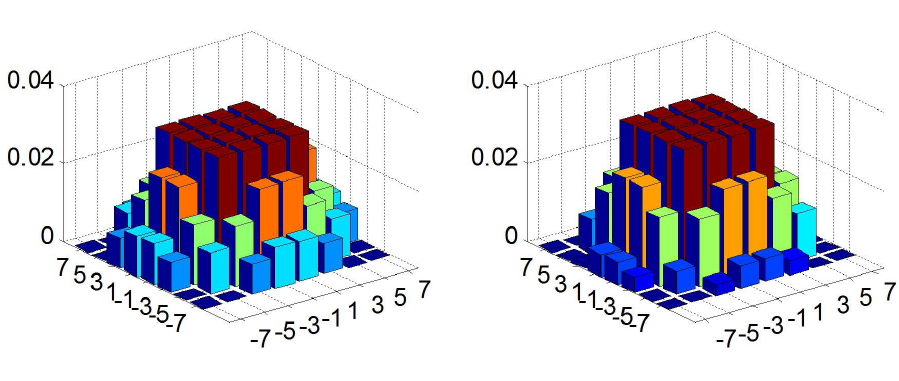
Figure 5. Probability distribution of the design object ( left ) and a feasible example ( right ).